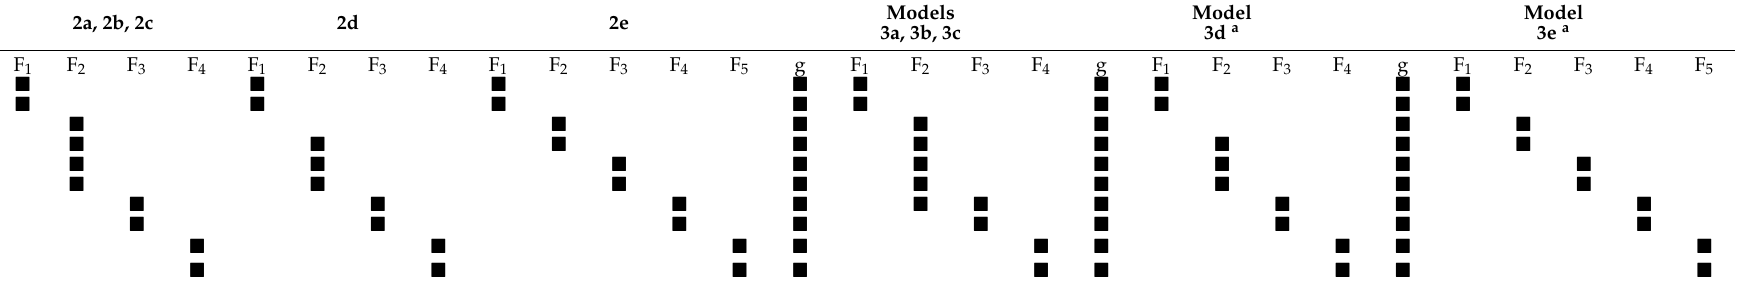
Note. Models 2a to 2e include a second-order general factor. Loadings on the general factor are constrained to equality in models 1a, 2a, 3a. Subtest loadings on first-order factors and group factors are constrained to equality in models 2a, 3a, 3b. In model 2c, error terms of ROV and RID are allowed to correlate. (cid:4) = subtest loads on the respective factor. NR = Number Recall; WO = Word Order; CT = Conceptual Thinking; PR = Pattern Reasoning; ROV = Rover; TRI = Triangles; ATL = Atlantis; REB = Rebus; EV = Expressive Vocabulary; RID = Riddles. a Only 6-year-olds. b Not included in Luria